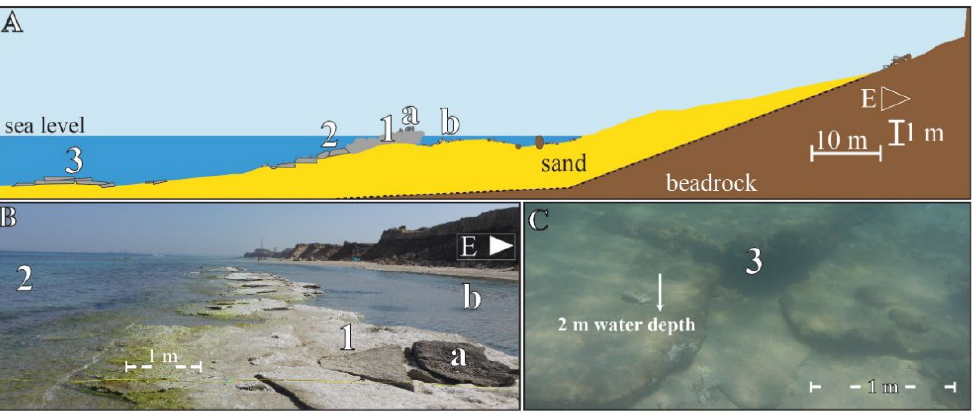
Figure 6. Beachrock exposure at Gador I site (north of Mikhmoret): ( A ) schematic cross-section of the site (VE = 4, 1 : in-situ BR outcrop, 2 : sea side part of the BR band on the shore face; 3 : submerged clasts of wide BR slabs at about 2.5 m water depth (which underwent settling), ( a ) clasts of BR plates on top of the in-situ outcrop, ( b ) clasts of BR boulders at the trough, dotted line marks uncertain unit contact depth); ( B ) view of the site (notes are the same as in ( A ); ( C ) closeup (looking west) on the submerged BR section, loose blocks up to 3 m long, which underwent settling.